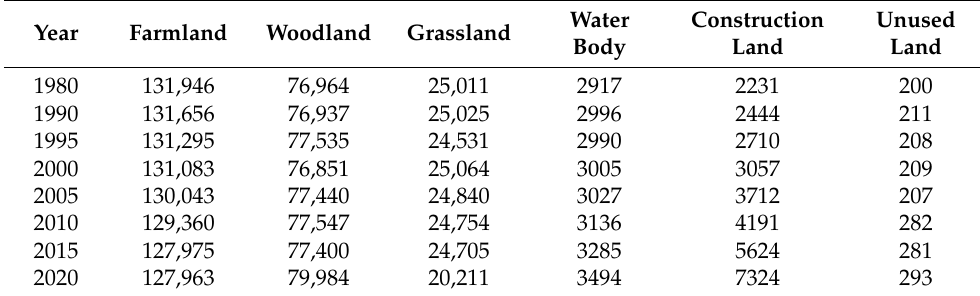
Table 3. Area of different land-use types in the Chengdu-Chongqing Megalopolis from 1980 to 2020 (unit: km 2